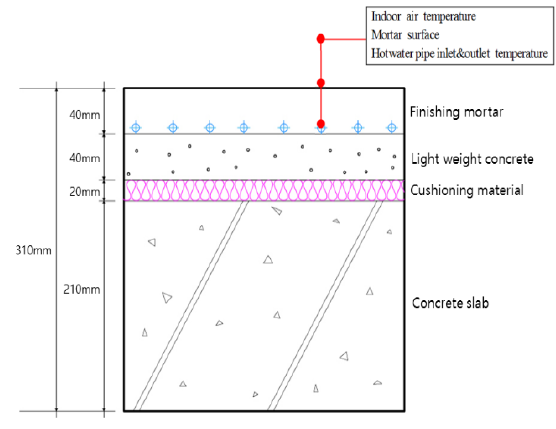
Figure 8. Sensor locations in the PCM-based radiant heating system.